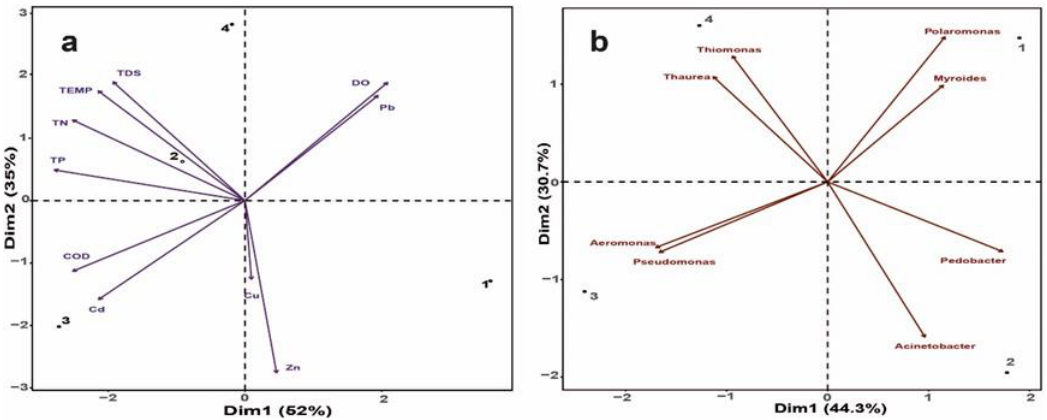
Figure 2. Principal component analysis (PCA). Where ( a ) explain the water quality variation is chemical factors and ( b ) explain the correlation with microorganism.